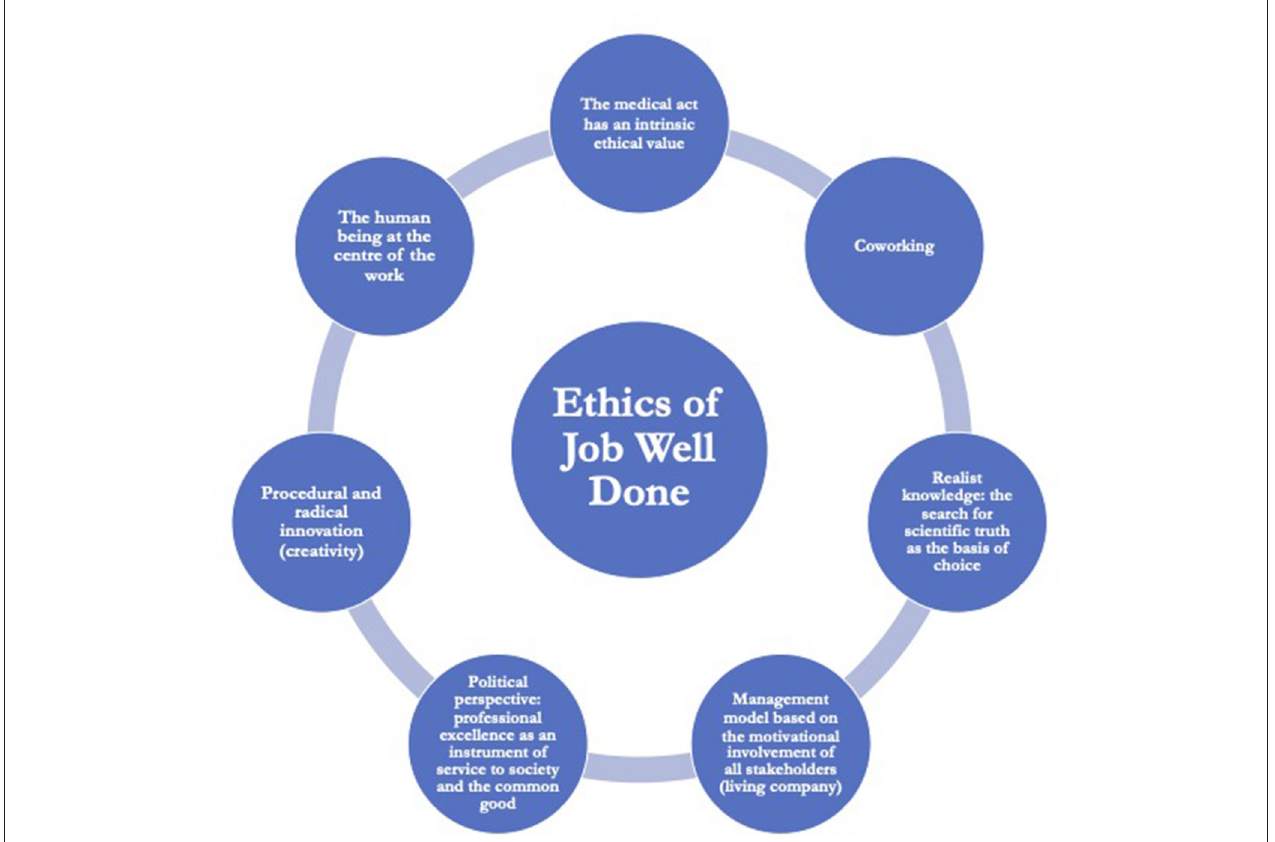
FIGURE 2 | Ethics of Job Well Done